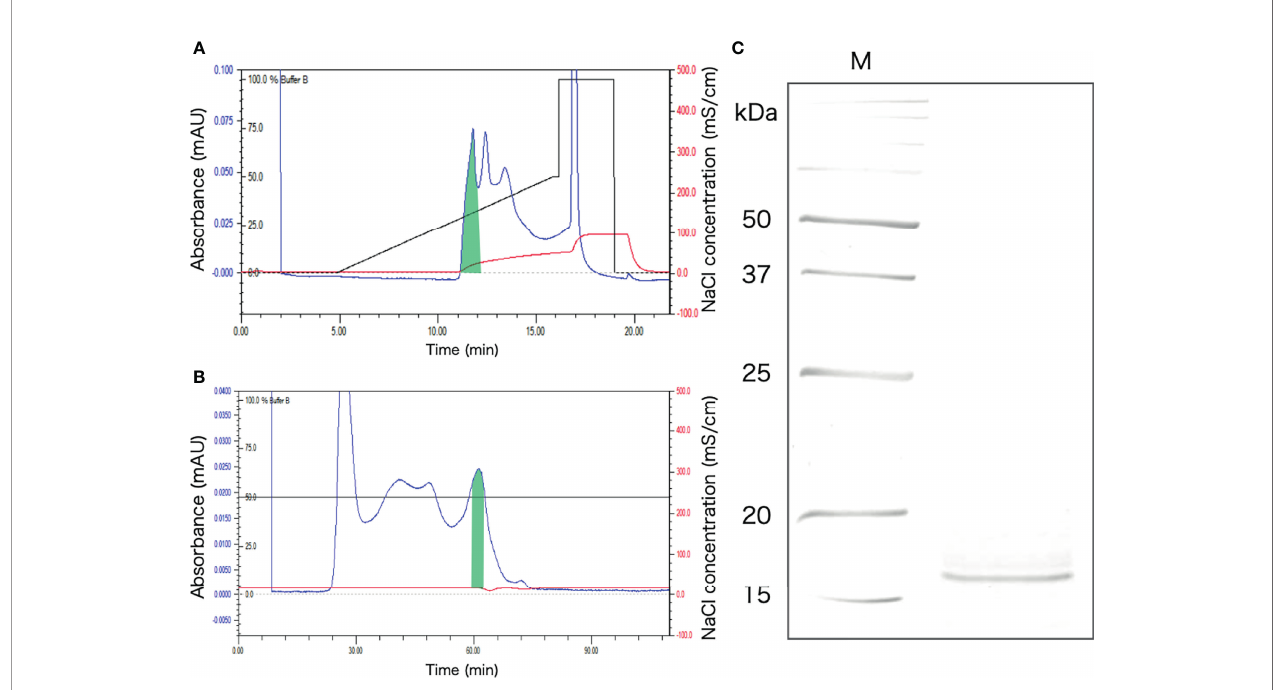
FIGURE 6 | Puri fi cation of the aggregation-promoting factor from the crude protein fraction of the intestinal extract. (A) Chromatogram after anion-exchange chromatography on a POROS HQ/20 column. The fraction with the activity is shaded. (B) Chromatogram after gel- fi ltration chromatography on a Superdex 200 column. The shaded fraction in Figure 4A was applied. A fraction with the activity is shaded. (C) SDS-PAGE of the shaded fraction in Figure 4B . A 15% polyacrylamide gel was used and was visualized by staining with coomassie brilliant blue. M, marker.